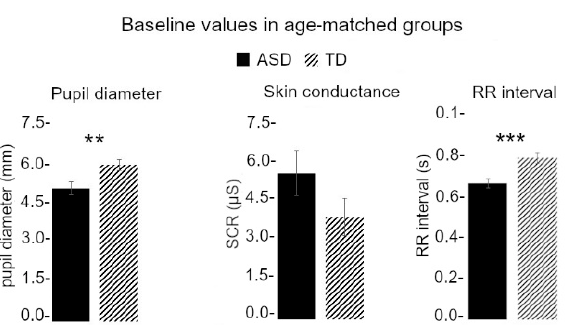
Figure 4. Baseline values of ANS parameters in ASD and age-matched TD groups. The figure indicates differences in the baseline pupil median diameter (mm) for the ASD (black/left columns) and TD age-matched group (hatched/right columns), baseline SCR ( µ S) and baseline RR interval (s). Results are expressed in mean value (± standard error). **: p < 0.01, ***: p < 0.001.